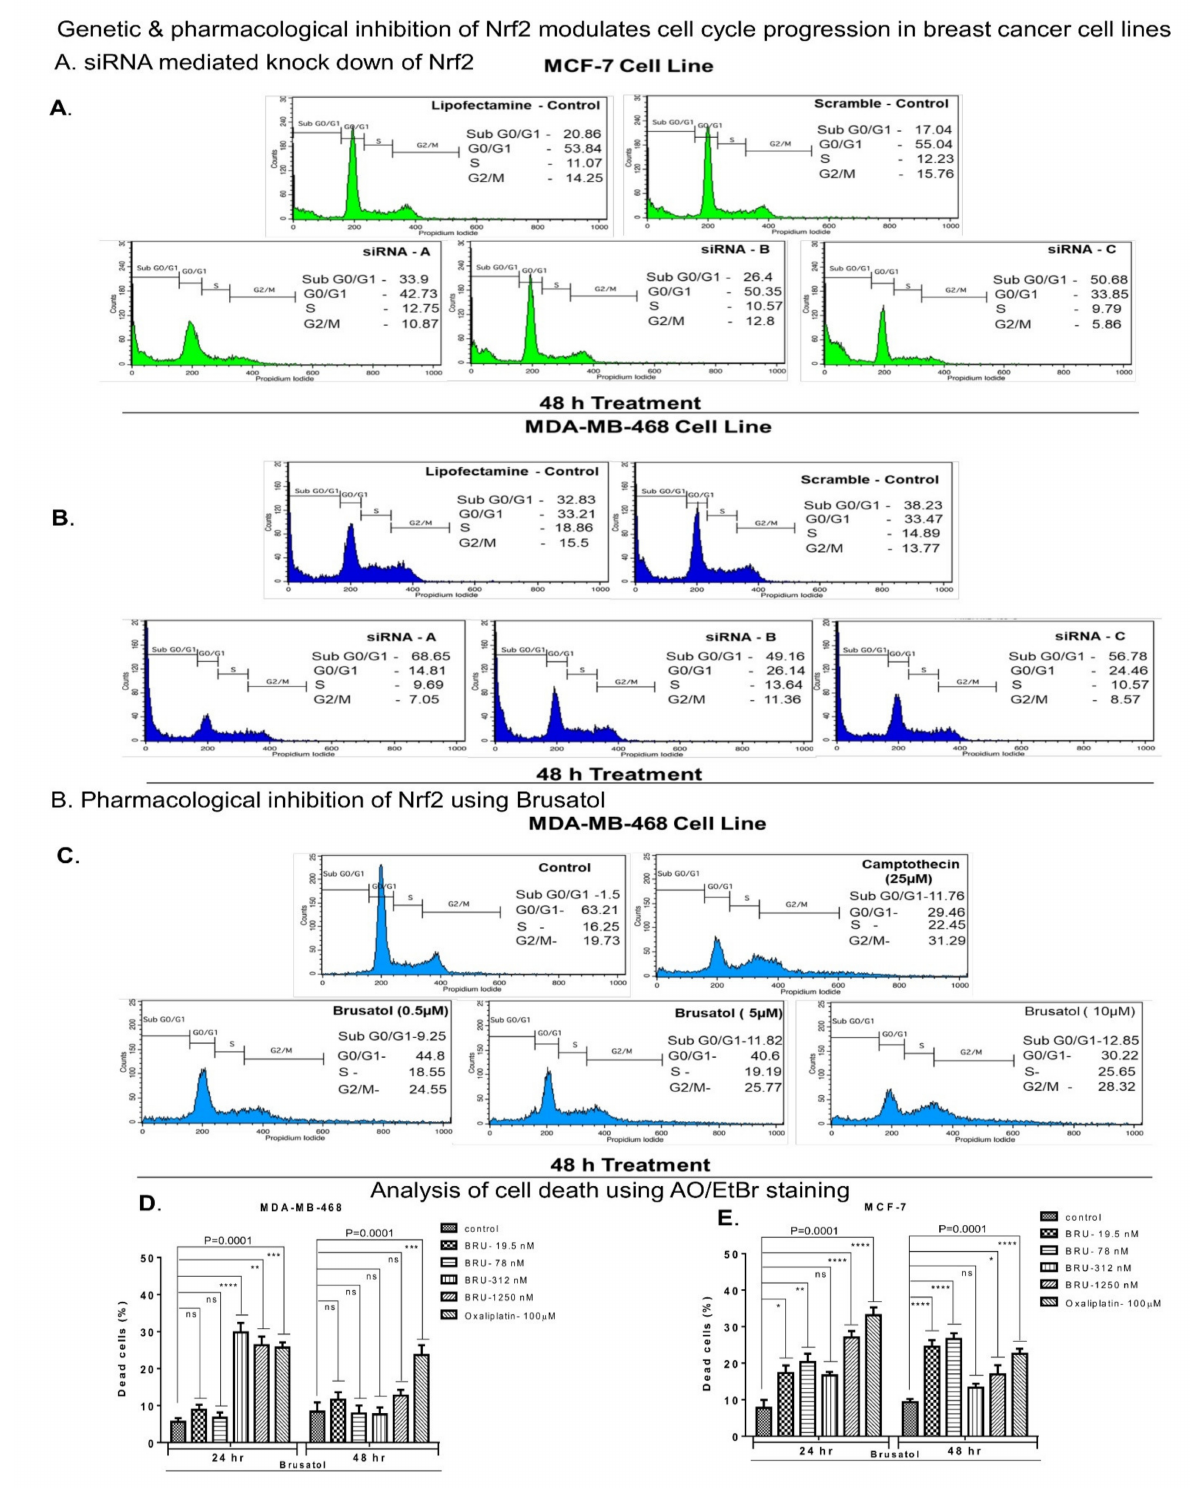
Figure 5. Inhibition of Nrf2 using siRNA and brusatol induced cell cycle arrest and promoted cell death in vitro: ( A , B ) cell cycle progression was measured using PI staining followed by FACS analysis of the stained cells. A significant increase